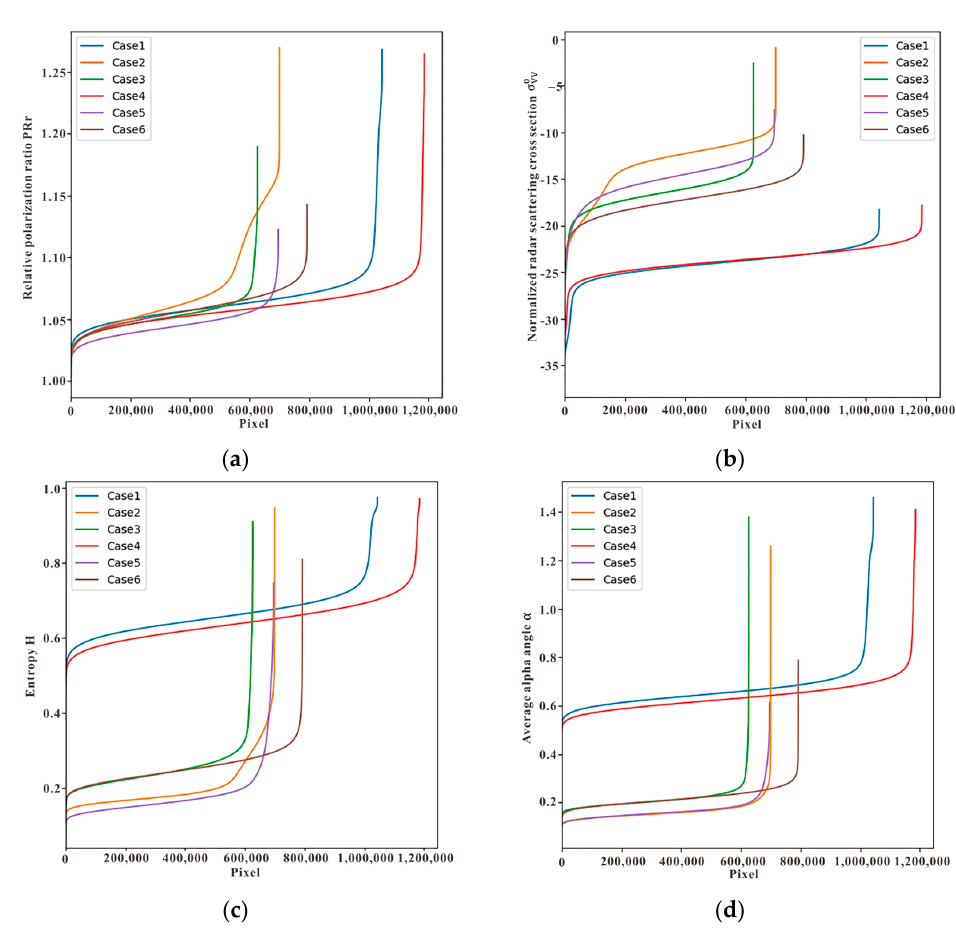
Figure 11. Numerical statistical comparison of different characteristics of six cases. ( a – d ) are based on PR r , σ 0 vv , H , and α ,